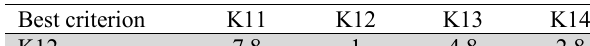
Actors and Networks sub-criteria BO Vector Best criterion K11